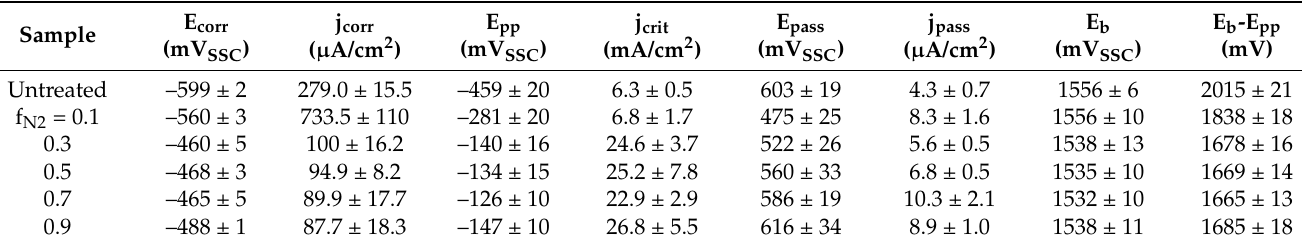
Figure 5. Polarisation curves in 0.25 M H 2 SO 4 for FeAl40 in untreated state and nitrided with varying N 2 –H 2 ratios within the plasma nitriding process: ( a ) polarisation curves, ( b ) electrochemical corrosion parameters and ( c ) Tafel extrapolation for determining of E corr and j corr . Table 3. Extracted electrochemical corrosion parameters from the polarisation curves presented in Figure